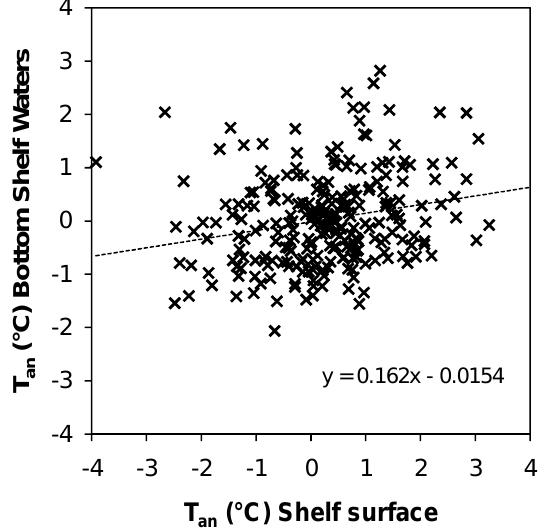
Correlation between monthly temperature anomalies (1950–2004) in the shelf surface layer (0–10m) and the BSW dur- ing the warm period (May–November).